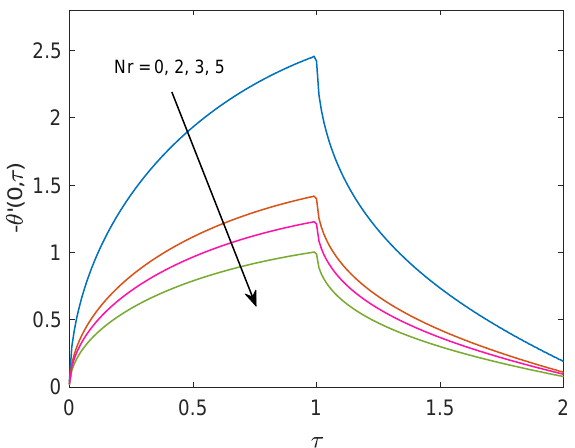
Figure 17. Nusselt number for different values of Nr.